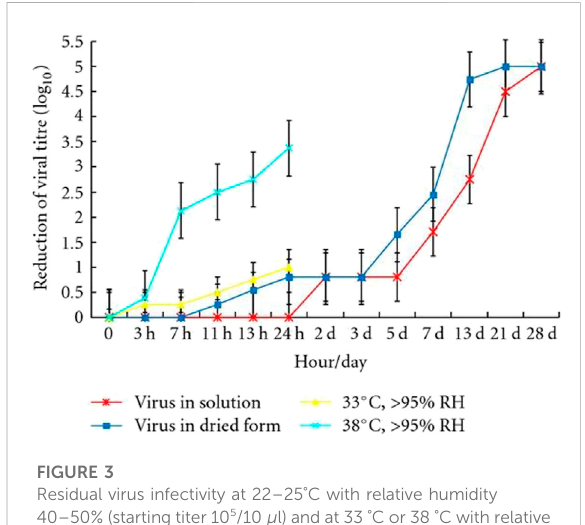
FIGURE 3 Residual virus infectivity at 22 – 25 ° C with relative